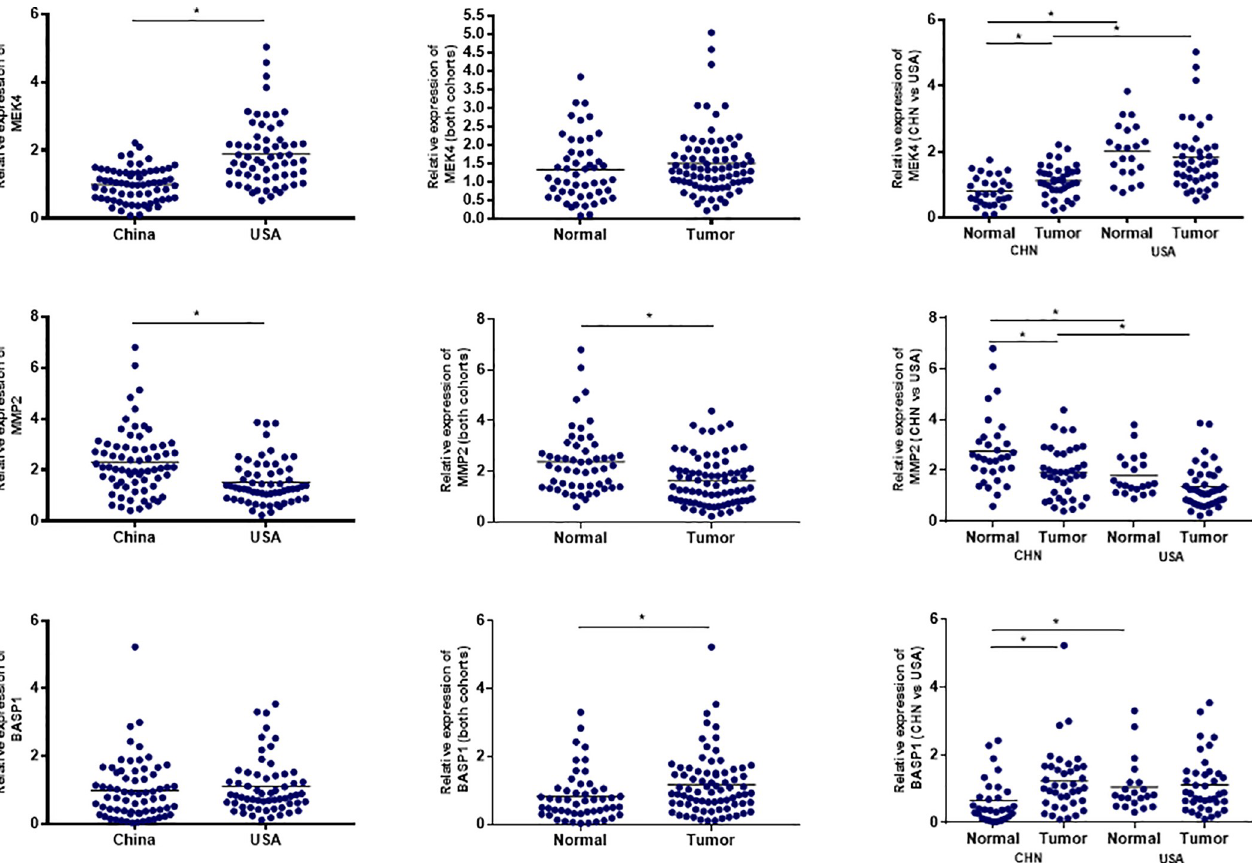
Fig 3. Expression of genes linked to regulation of genistein efficacy in prostate tissue from Chinese and US men. The expression of MEK4, MMP-2 and BASP1 was measured by qRT/PCR in normal and cancer containing prostate tissue from N = 38 Chinese and N = 41 US men. Data are relative expression values, normalized to GAPDH, ATP5E and PGK1, for individual patients, with � denoting Student’s t-test P-values < / = 0.05 between the indicated